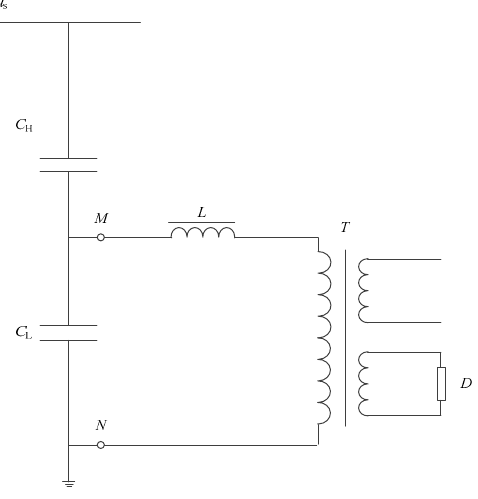
Figure 1. Structure of capacitive voltage transformer (CVT).